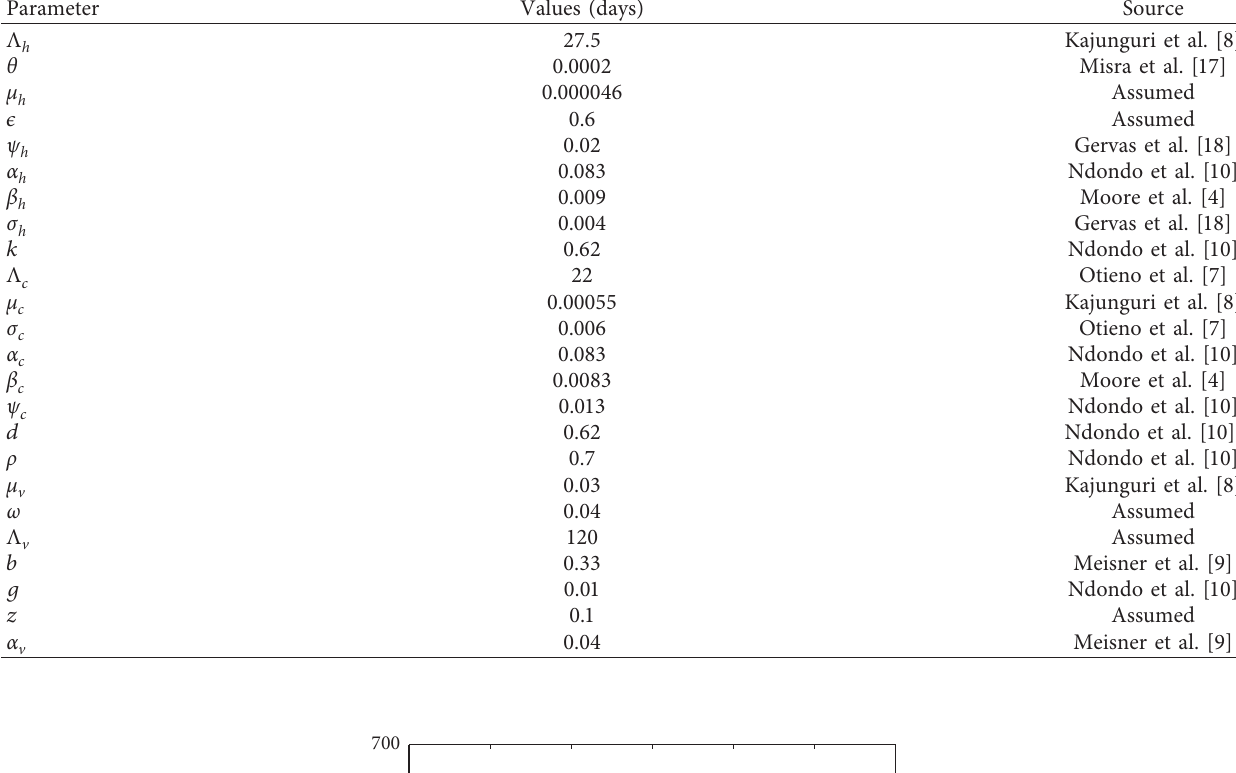
Table 4: Epidemiological data for model (4).